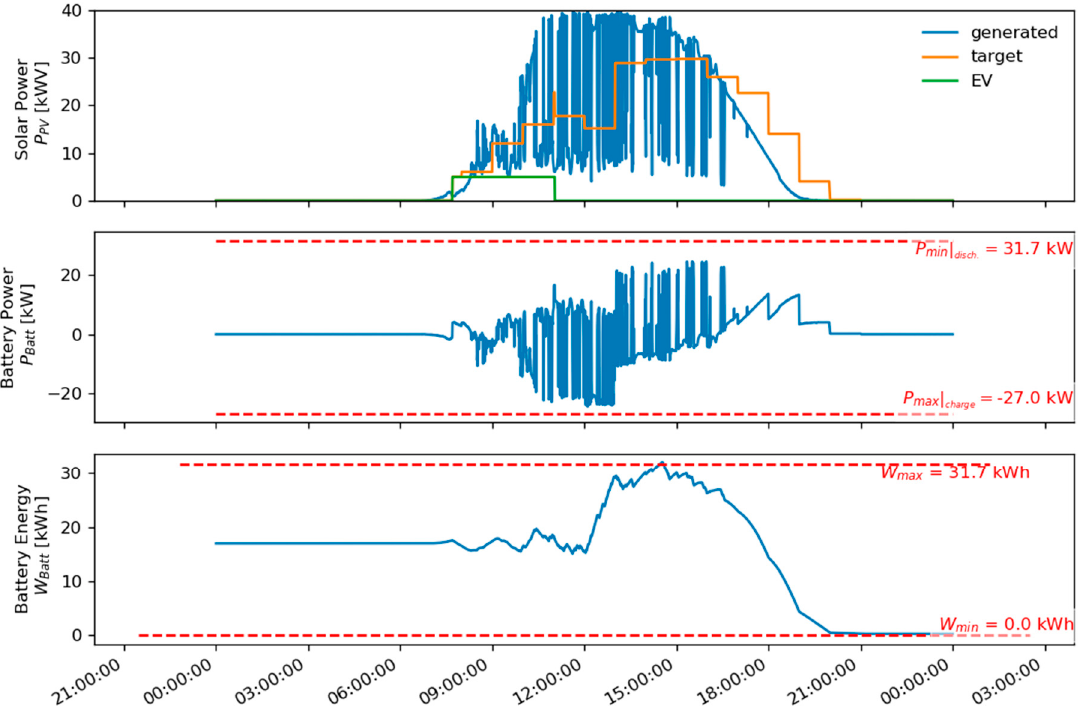
Figure 8. A day of regulated solar intermittency, outputting hour-average PV power with one hour delay with offsetting EV charging during morning hours.